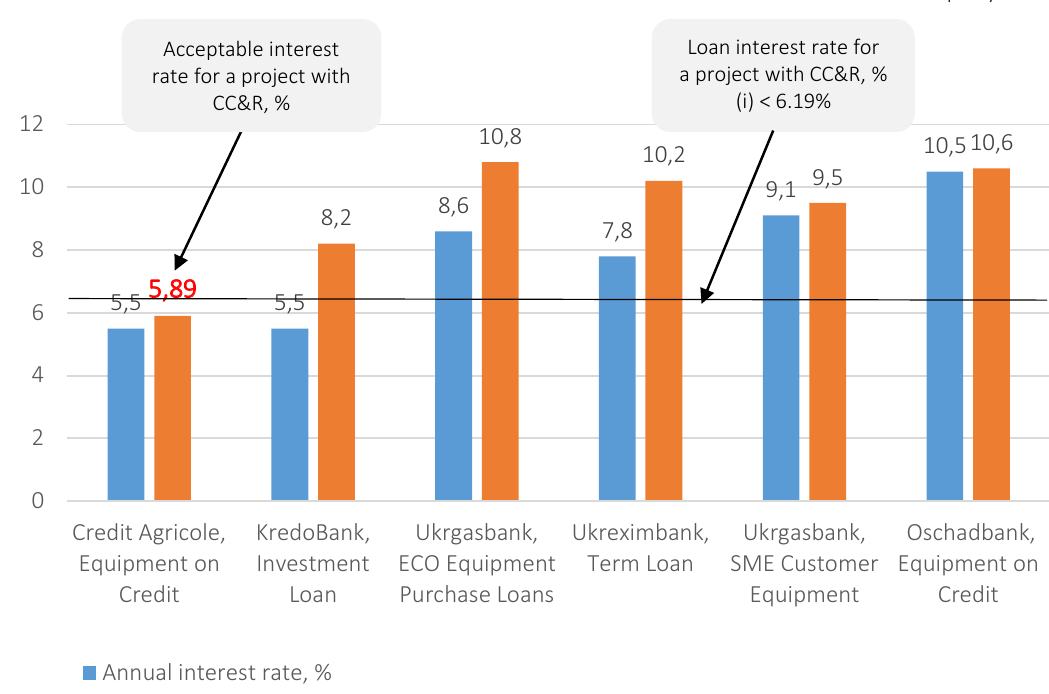
Figure 3. Acceptable interest rate for a project with financial covenants, %